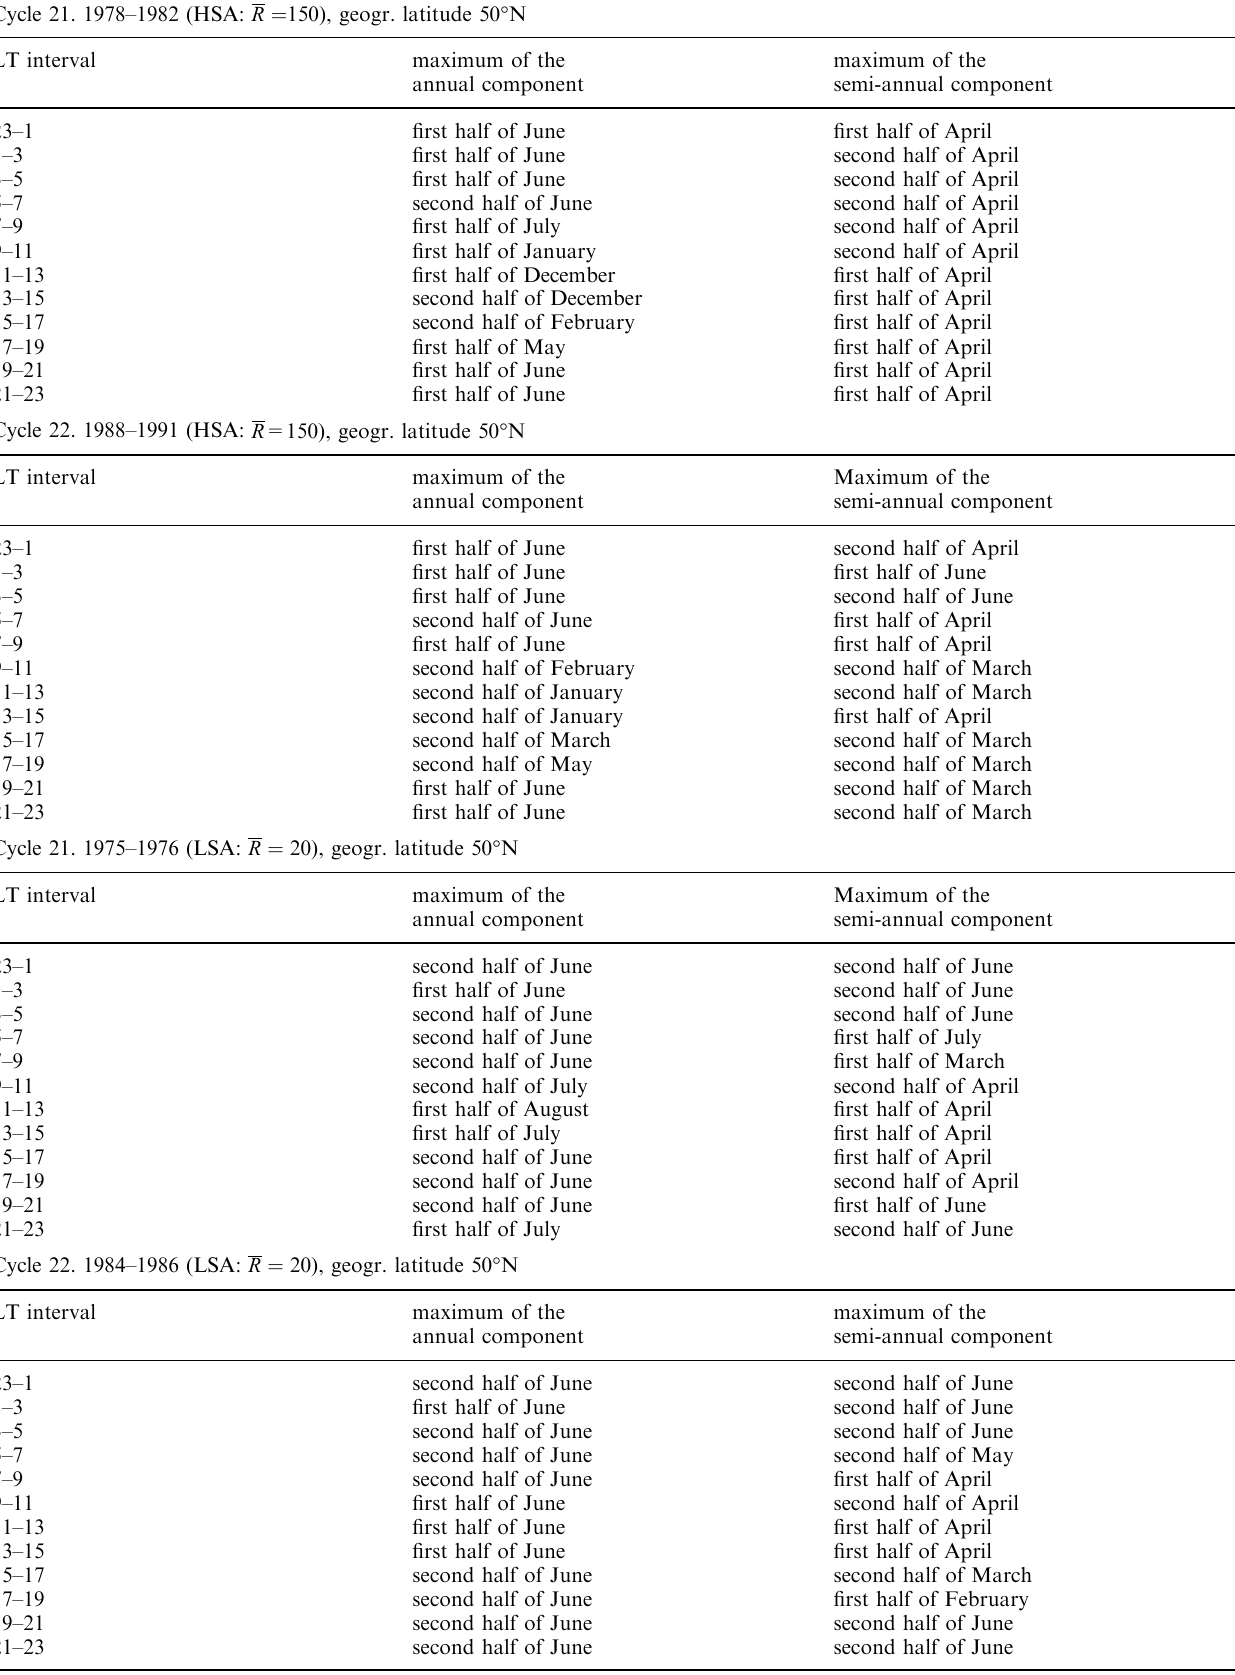
Table 4. Occurence of the maxima of the annual and semi-annual Fourier components of TEC for solar cycles 21 and 22 Cycle 21. 1978–1982 (HSA: R (cid:136) 150), geogr. latitude 50 (cid:176)